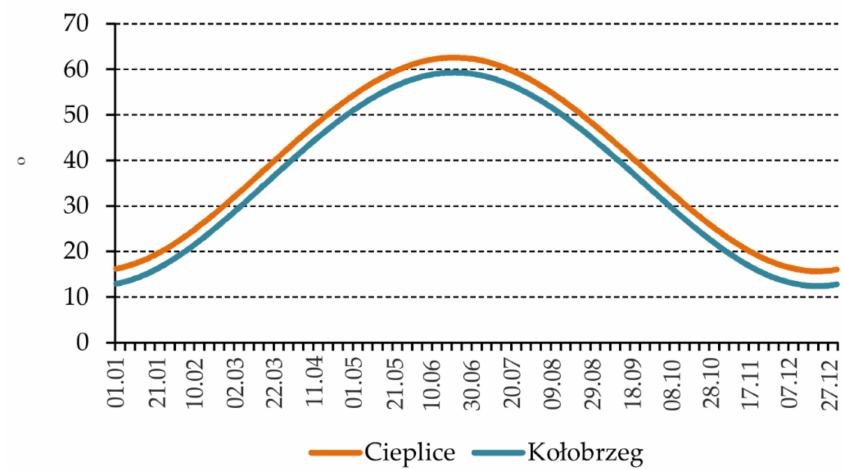
Figure 12. The maximum height of the sun in the following days of the year in Cieplice and